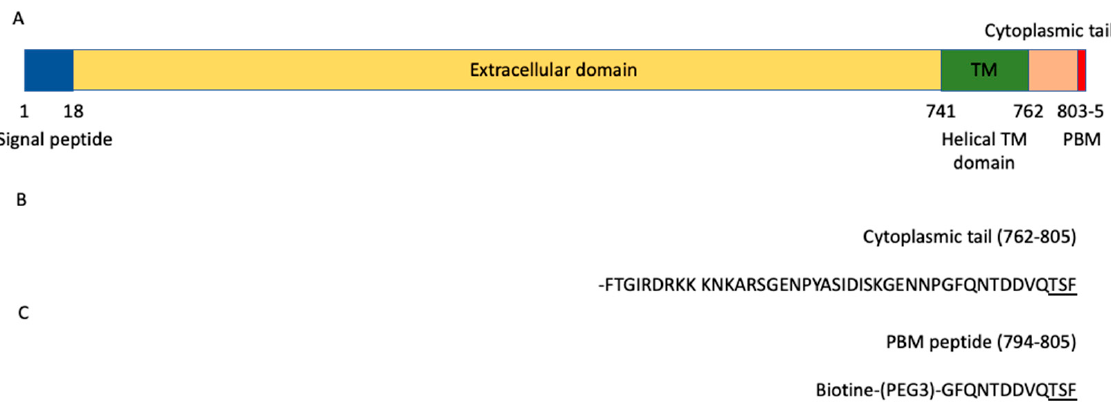
Figure 1. ACE2 domain organization. ( A ) Schematic domain organization of the ACE2 protein. ( B ) Sequence of the cytoplasmic tail (762–805) of ACE2. ( C ) Sequence of the peptide used in the holdup assay. The PBM is underlined in the sequences.